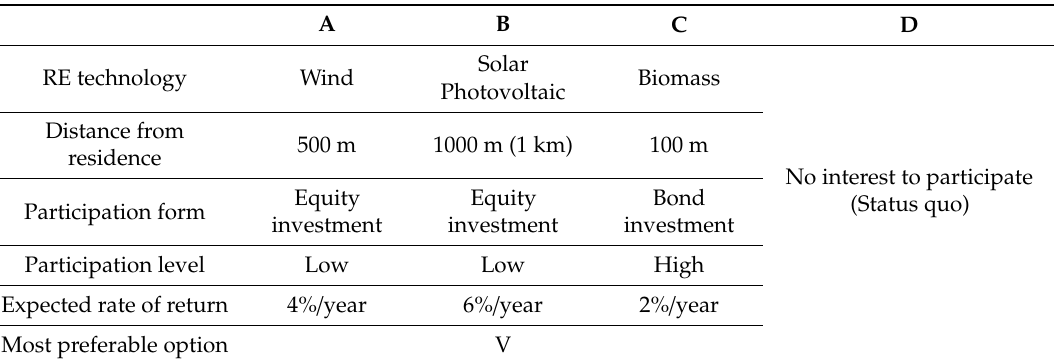
Table 2. A sample choice